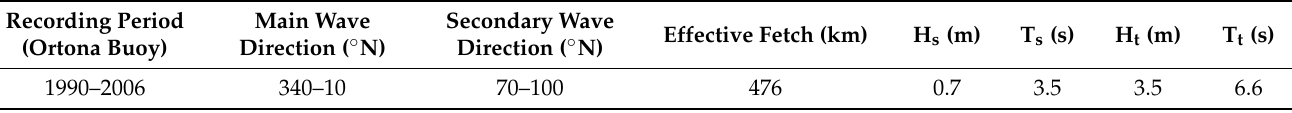
Table 1. Main wave climate features estimated for the Molise coast. Average Significant Wave Height ( H s ) and the associated period ( T s ); Average Significant Wave Height of events exceeding 2 m ( H t ) and the corresponding period ( T t